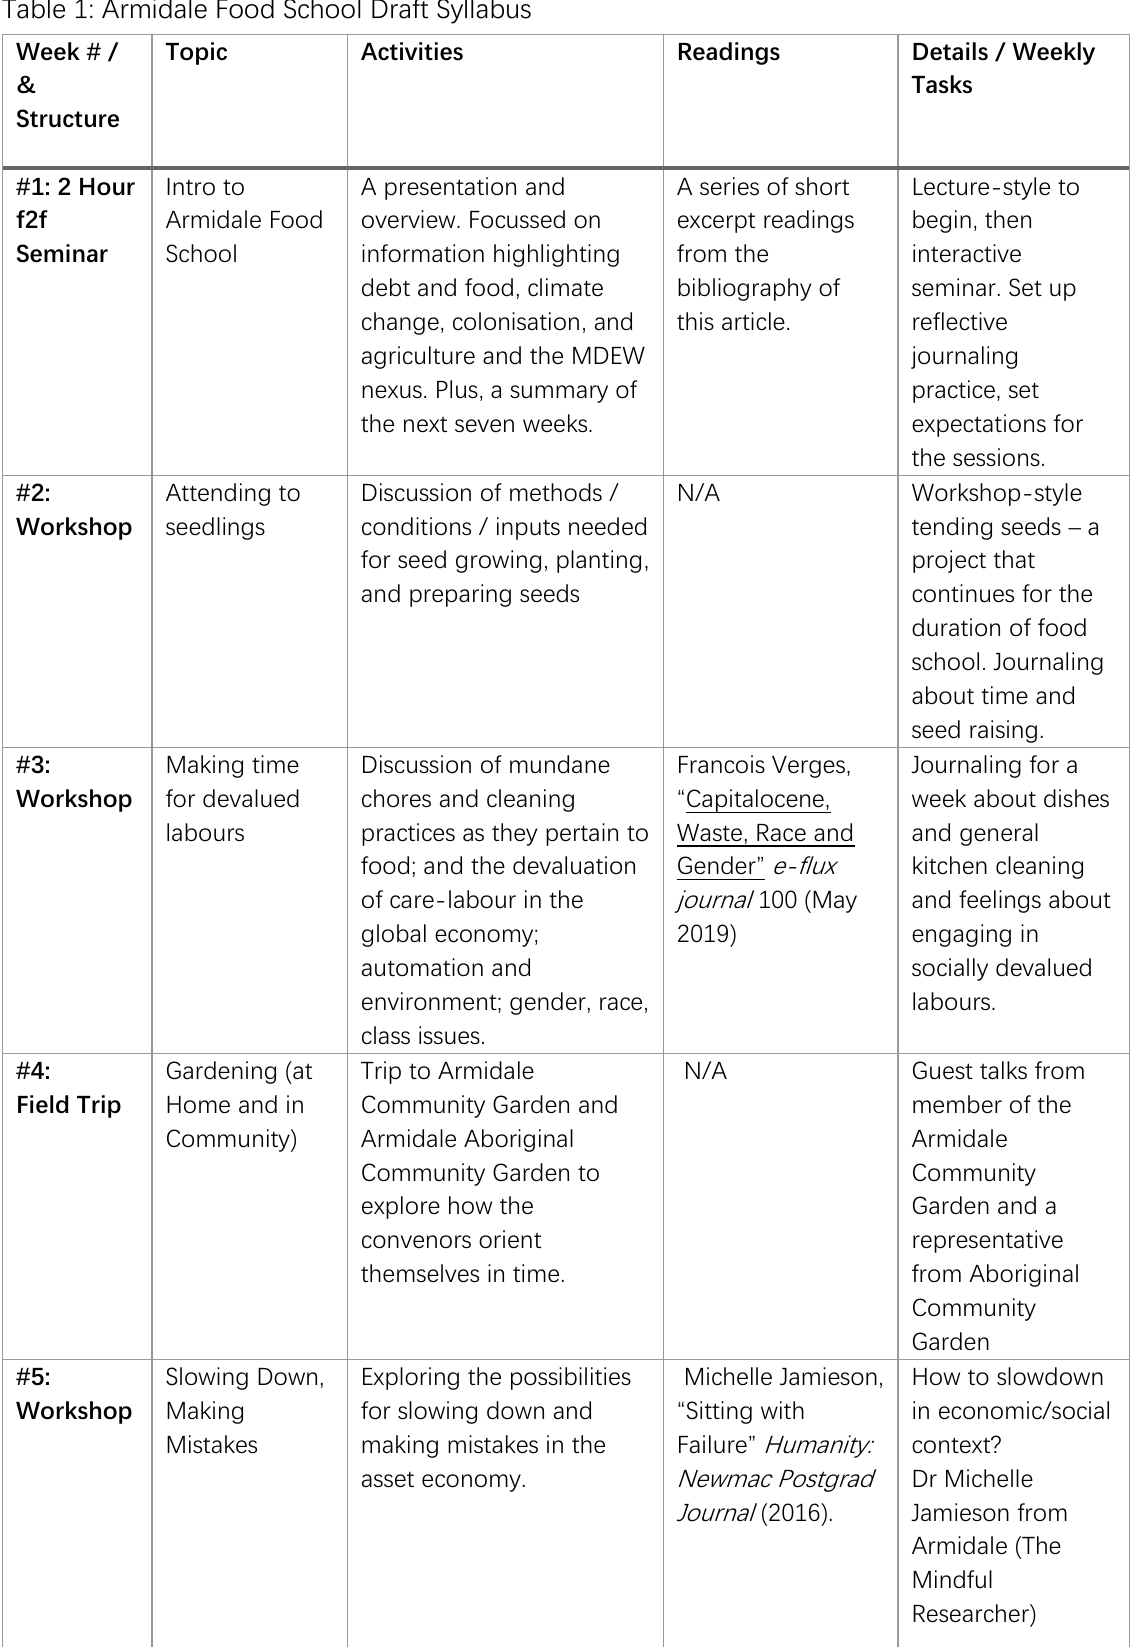
Table 1: Armidale Food School Draft Syllabus Week #